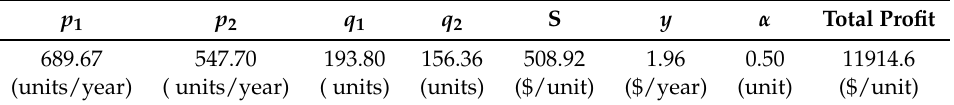
Table 7. Optimum results of Example 3.